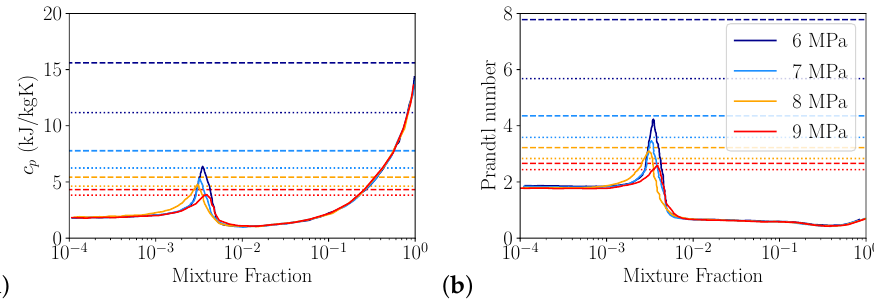
Figure 2. Isobaric specific heat capacity c p ( a ) and Prandtl number Pr ( b ) sampled in computational mesh; data from Lacaze and Oefelein [37]. Actual c p peak value as horizontal lines from reference data (NIST): dashed; Peng-Robinson: dotted. Table 1. Fluid property sampling error in [37]. Reference data from NIST